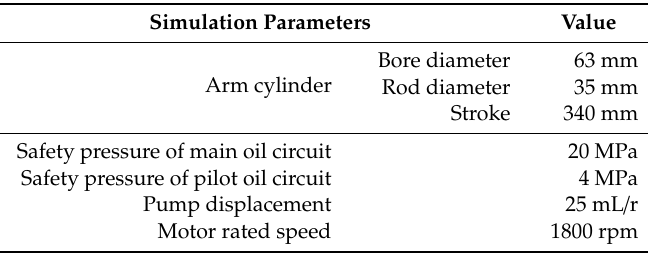
Table 1. Simulation parameters of positive flow system (PFS) based on variable speed control.